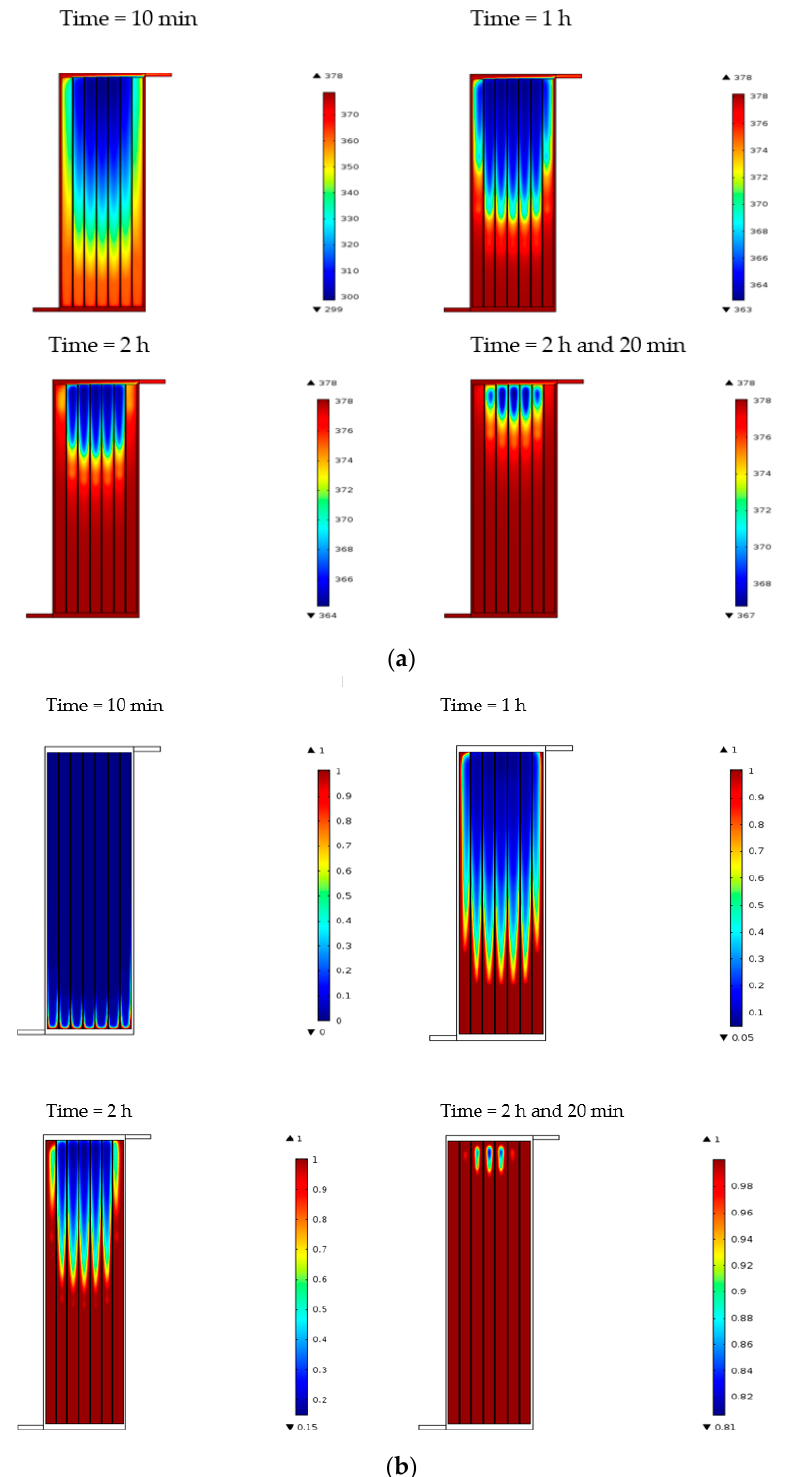
Figure 2. ( a ) Temperature for 10 min, 1 h, 2 h and 2 h and 20 min; ( b ) Liquid level temperature for 10 min, 1 h, 2 h and 2 h and 20 min. 10 min, 1 h, 2 h and 2 h and 20